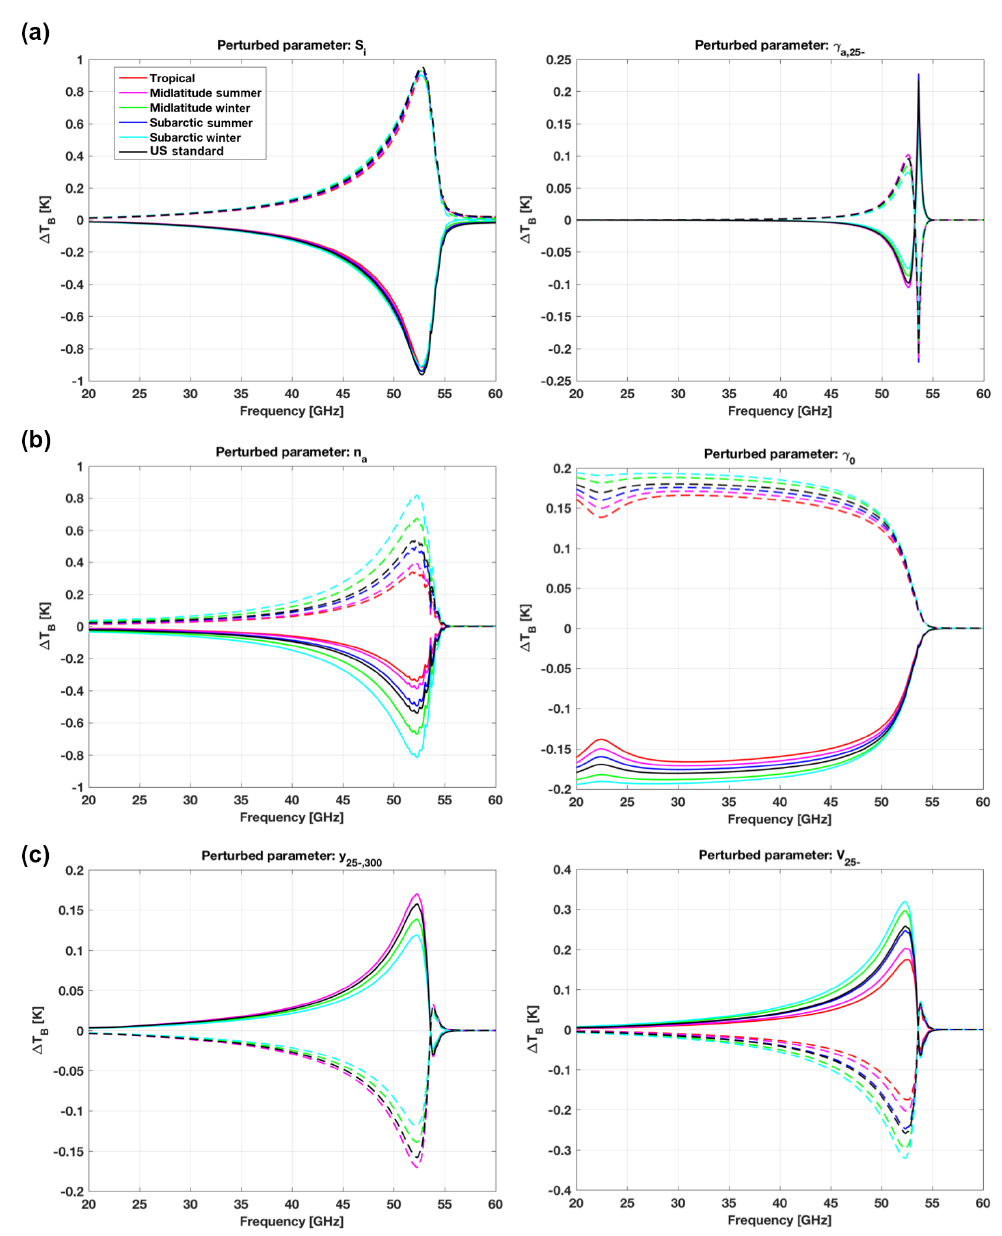
Figure 3. Sensitivity of modeled T B to oxygen absorption parameters. (a) Line intensity ( S i ) and air broadening ( γ i, a ). (b) Air-broadening temperature-dependence exponents ( n a ) and nonresonant pseudo-line broadening ( γ nr ). (c) Mixing coefficients ( y i ) and mixing temperature- dependence coefficients ( V i ). Note that the perturbation to S i and n a affect all lines, while for the other resonant line parameters we show the impact of the perturbation to just one line ( N = 25 − ) as an example. Solid lines correspond to negative perturbation (value − uncertainty), while dashed lines correspond to positive perturbation (value +